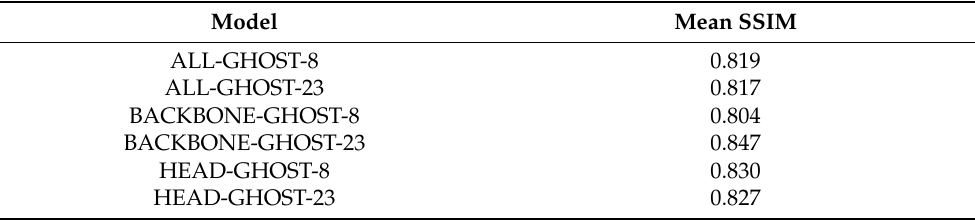
Figure 7. Heatmaps of SSIM compared to original images. ALL-GHOST-8 and ALL-GHOST-23 means the output of the eighth and the twenty-third layer in which the Ghost module is added both